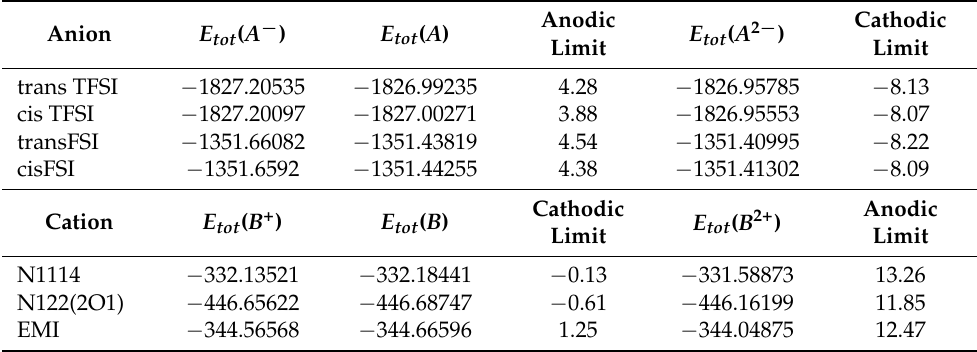
Table 2. Electronic energy (in atomic units) of anions and cations and their unrelaxed neutral or double charged forms calculated at the B3LYP/6 − 31G** level of theory and derived anodic and cathodic limits (V).